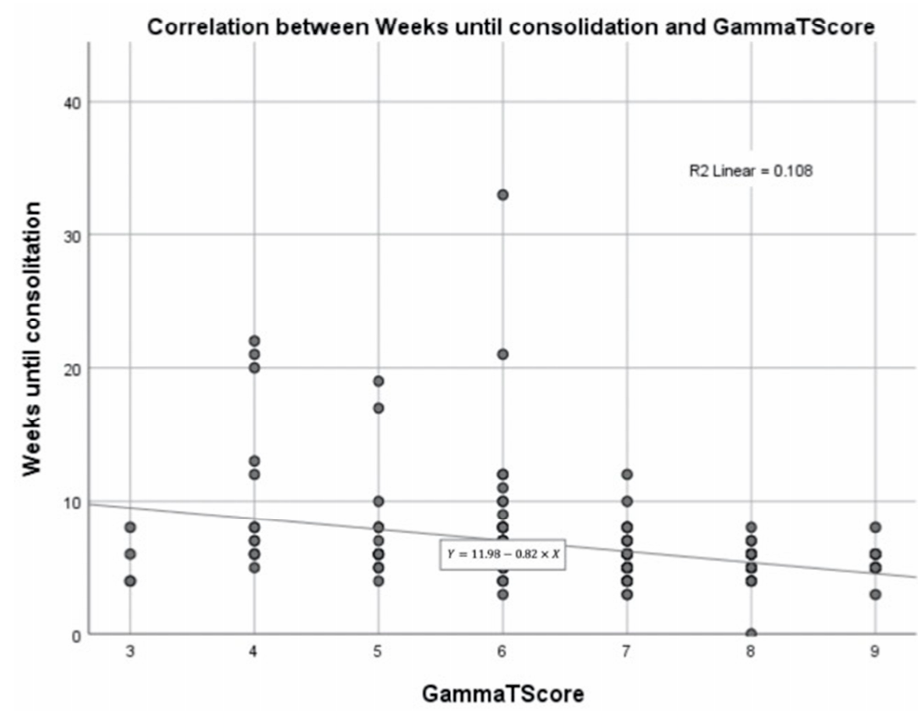
Figure 5. Correlation between weeks until consolidation and GammaTScore.